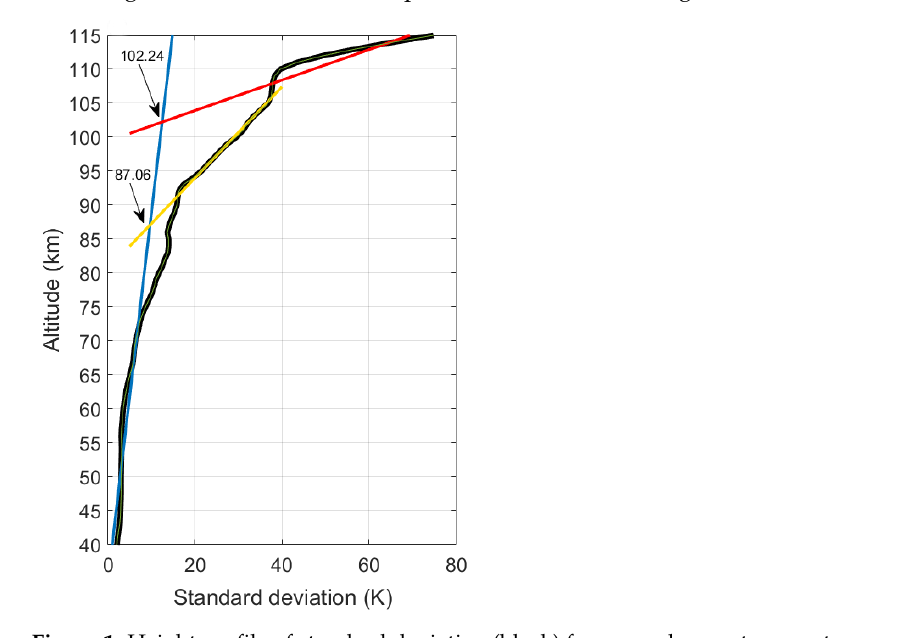
Figure 1. Height profile of standard deviation (black) from zonal mean temperature corresponding to 50 ◦ S latitude during January 2004. The blue, yellow, and red lines correspond to the straight-line fits at 40–75 km, 95–100 km, and 105–115 km, respectively. The straight lines intersect at the “wave turbopause” layer’s lower and higher boundaries.